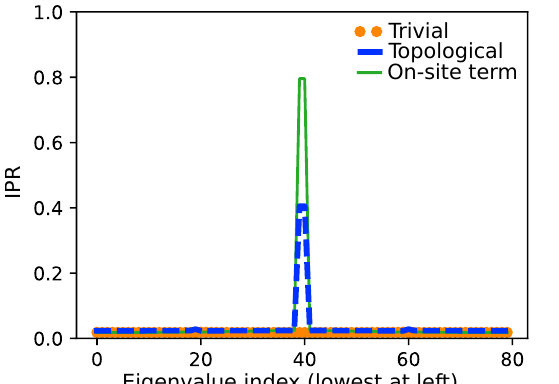
Figure 3. Inverse participation ratio (IPR) for each eigenvalue of a N = 80 SSH chain. The trivial ( β = 3, β (cid:48) = 1), topological ( β = 1, β (cid:48) = 3) and a non-topological case ( β = 1, β (cid:48) = 3, ∆ V = 2) were calculated. While the IPR is a an excellent tool to sort out edge states, it is not specific to the system’s chiral symmetry.